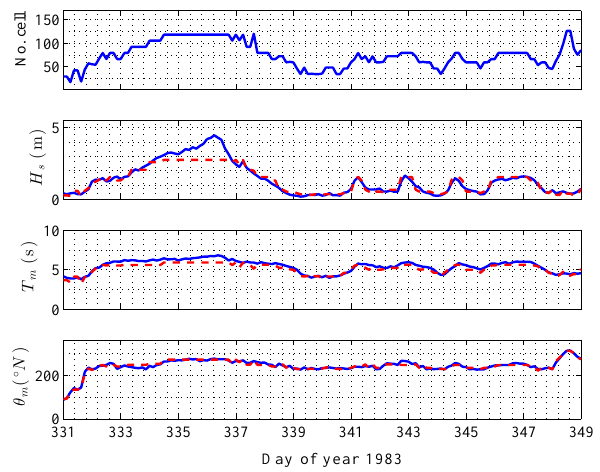
Figure 5. Single-step SOM: BMU cells (top panel) and comparison between original (blue solid lines) and reconstructed (red dashed lines) time series of H s (central-top panel), T m (central-bottom panel) and θ m (bottom panel), for a chosen sequence of events.